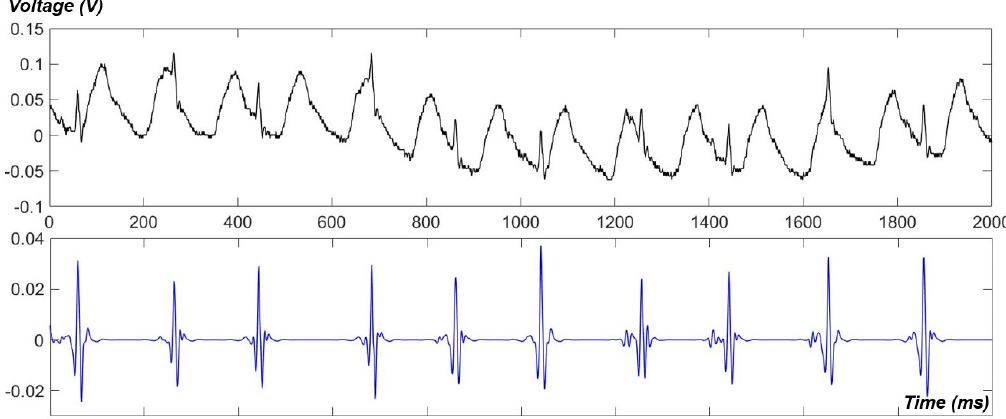
Figure 6. ECG signals, raw ( upper ) and de-noised ( lower ), recorded from an awake fish, using our newly developed PDMS apparatus.